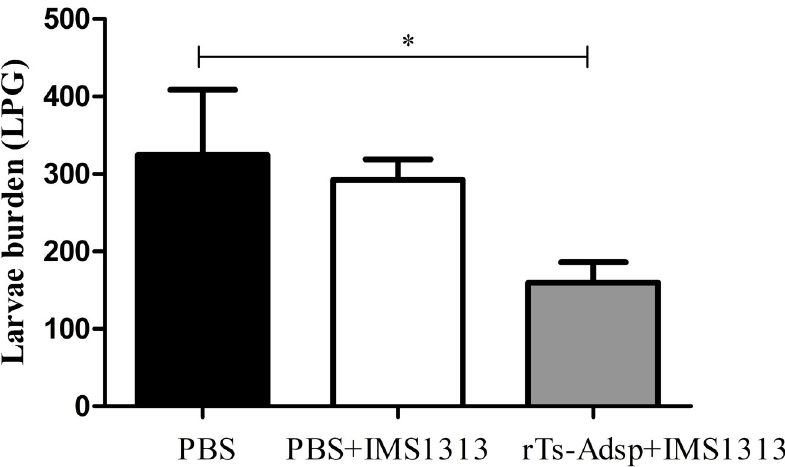
Fig 7. Protective immunity of rTs-Adsp-vaccinated pigs after being challenged with 5000 Trichinella spiralis larvae. The results are shown as the mean ± SD (n = 6). Asterisks indicate that muscle larvae burden of immunized group is significantly different from ( � p < 0.05) that of PBS control